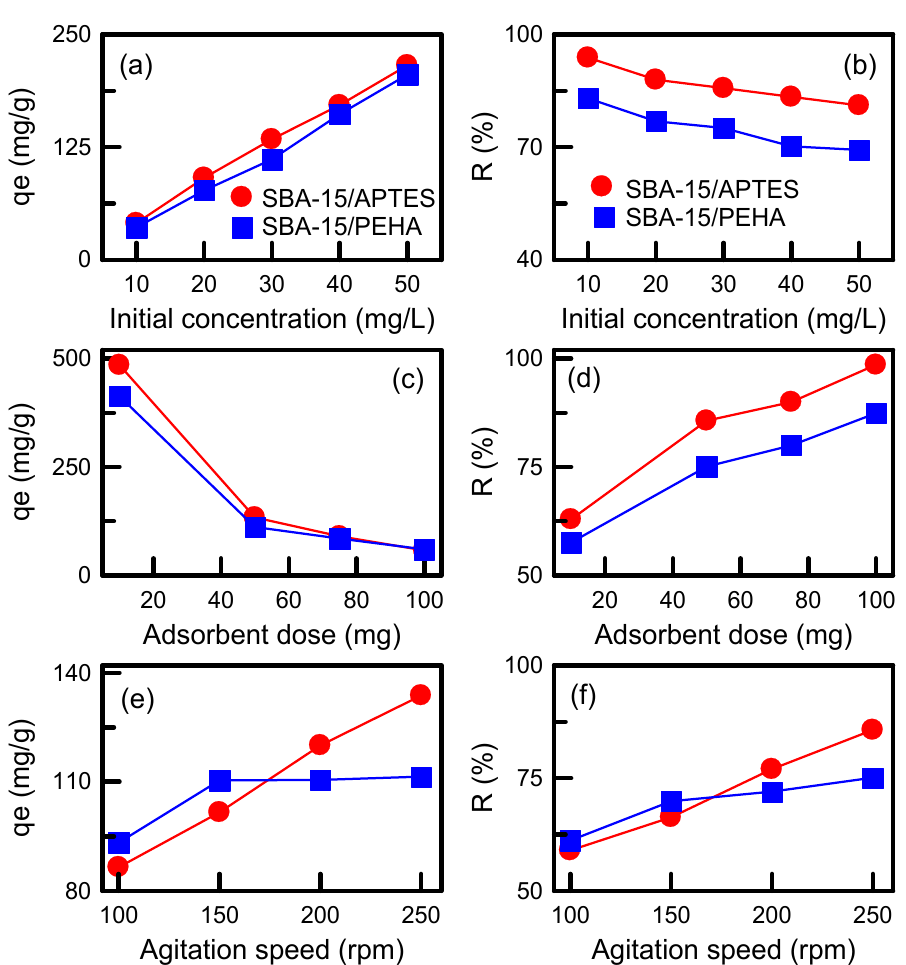
Figure 9. Effects of various adsorption conditions on the adsorption capacity and removal efficiency of adsorbents: ( a , b ) Initial TA concentration; ( c , d ) adsorbent dosage; ( e , f ) agitation speed.